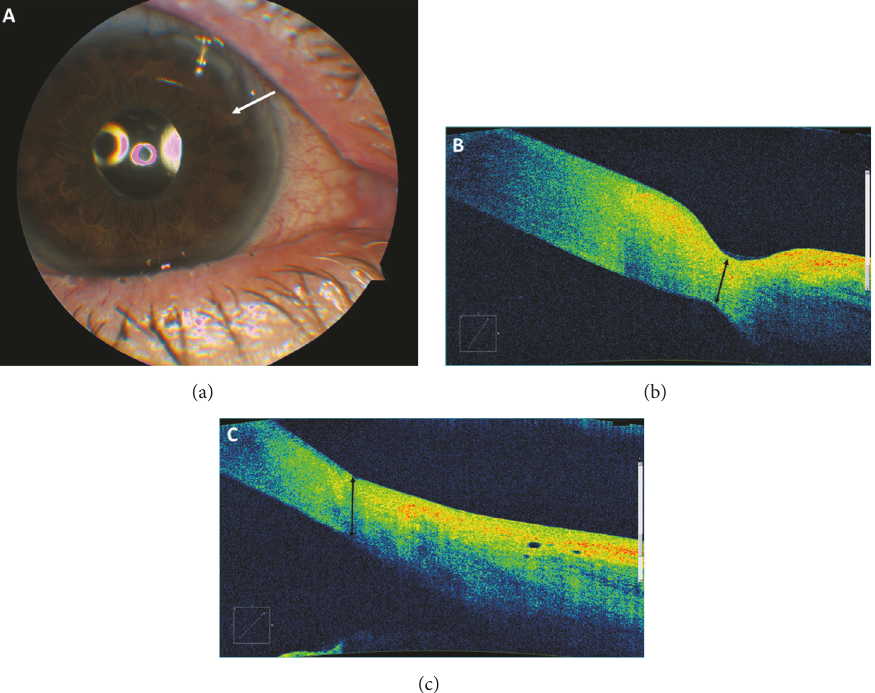
Figure 1: Superotemporal limbal ulcer of Patient 1. Panel (a) : slit-lamp examination (white arrow indicates primary area of thinning). Panel (b) : AS-OCT image at presentation demonstrating area of significant ulceration and thinning measured at 380 microns. The interface of the abnormal and normal cornea appears to be the most hyperreflective, which may be a sign of higher density of cellular materials in this region. Panel (c) : AS-OCT six months after presentation with flattening of the ulcer and subsequent improvement of thinning to 537 microns after medical therapy. The cystic region that remains to the right of the arrow may be an area of abnormal